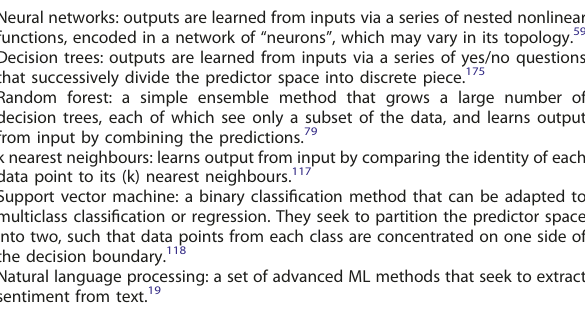
Box 1 Popular supervised machine learning